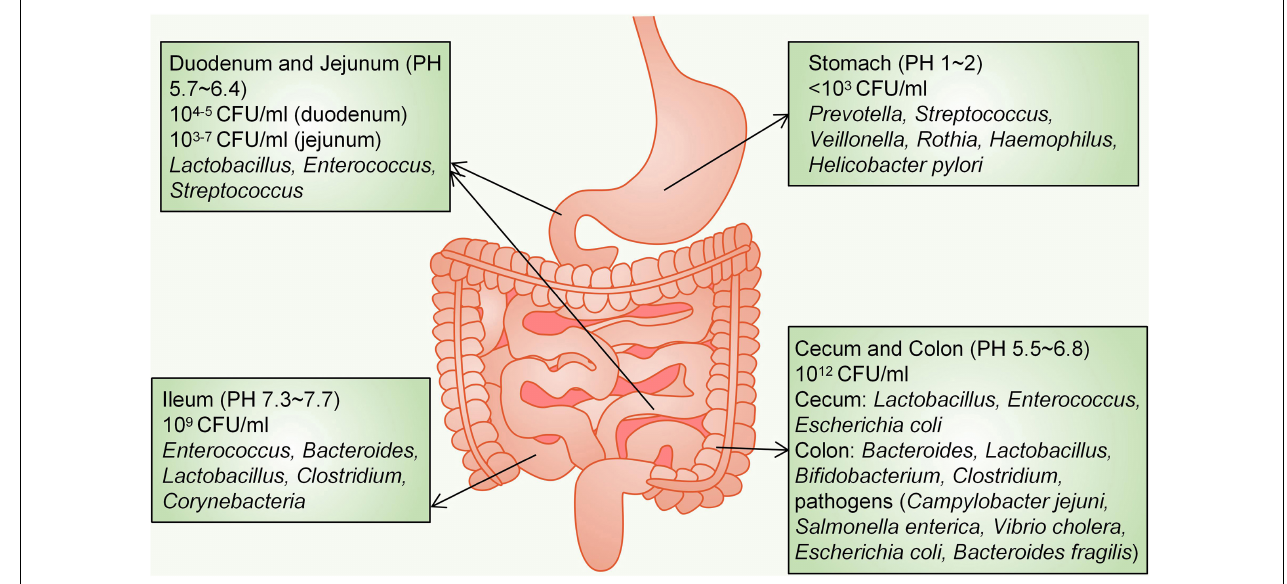
FIGURE 1 | Distribution of microorganisms in the gastrointestinal tract. CFU, colony-forming